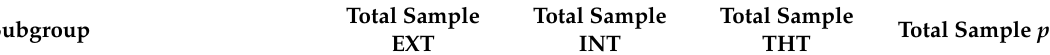
Table 5. Total Sample and Within Subgroup p -factor